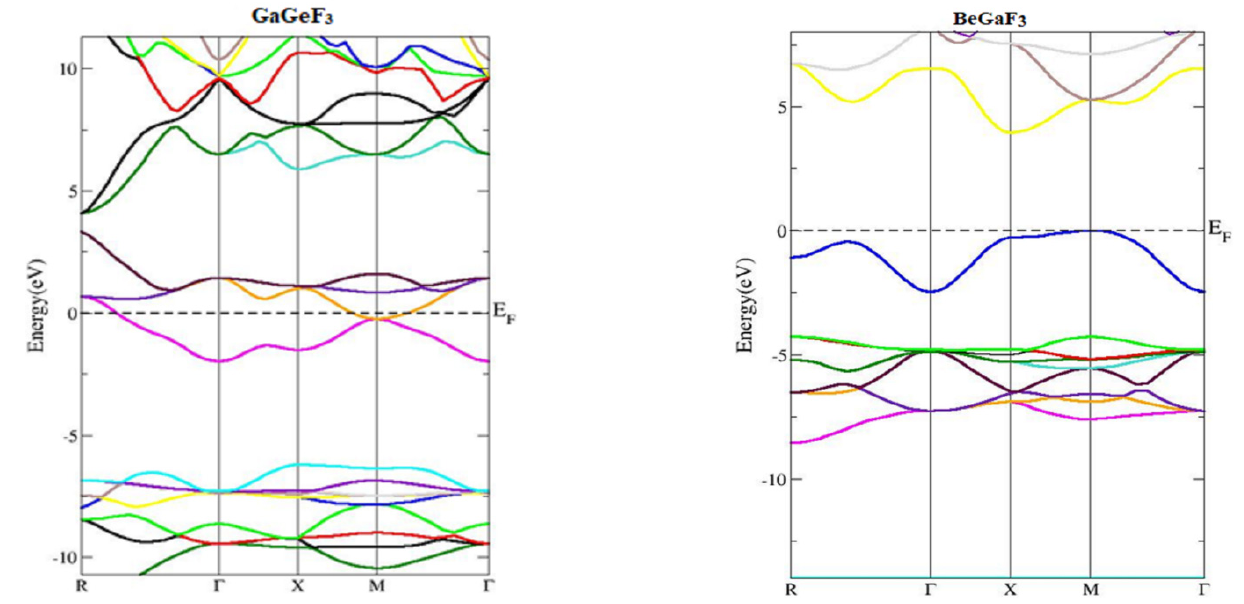
Figure 3. Energy band structures of compounds GaMF 3 (M = Ge and Be), using TB-mBJ approximation.